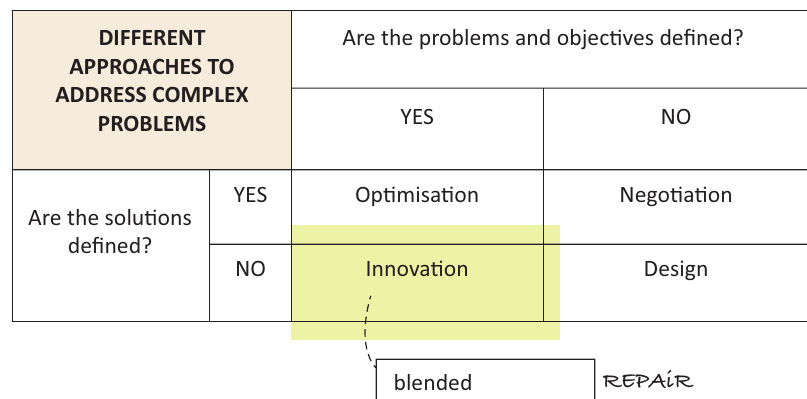
Figure 4. Different approaches to address complex problems based on van de Ven et al. (2009). Urban Planning, 2019, Volume 4, Issue 3, Pages